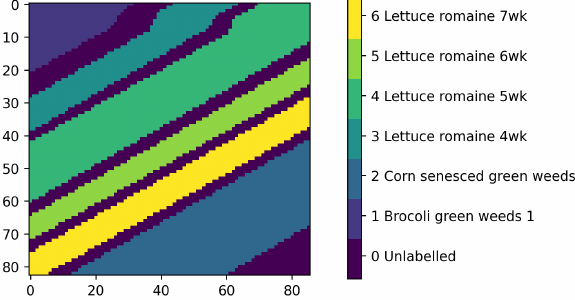
Figure 3: Visualization of the Salinas A scene ground truth. The image size is 83 x 86 pixels with 204 spectral